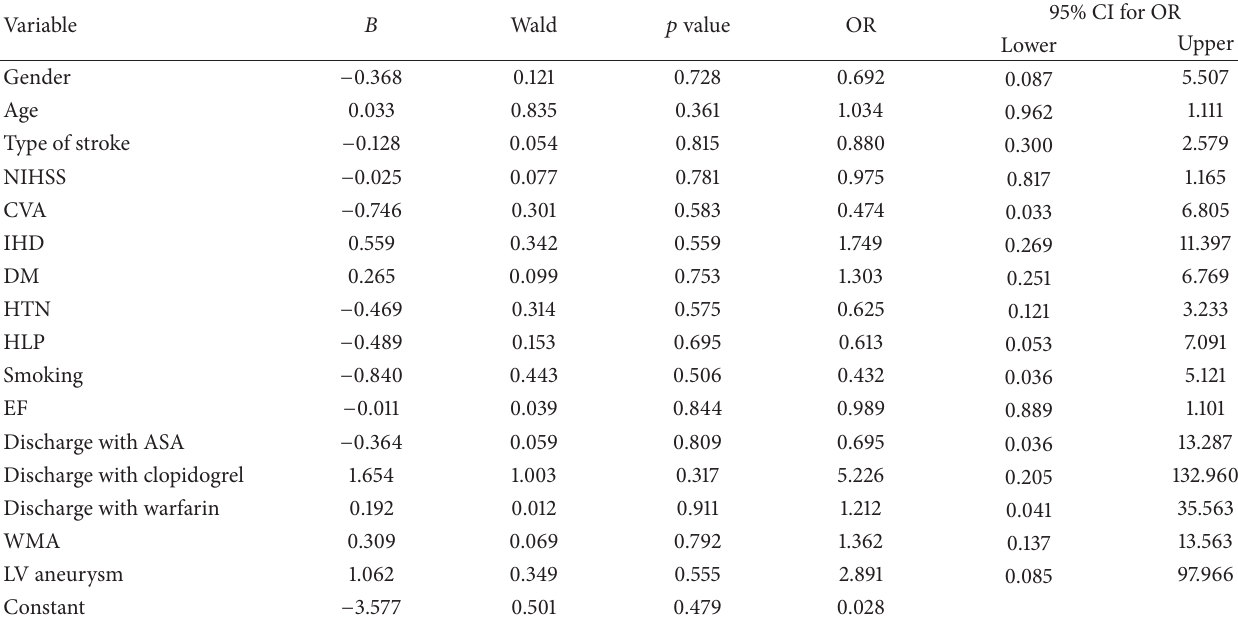
Table 2: Multivariate logistic regression analysis to determine predictors of recurrent brain stroke.